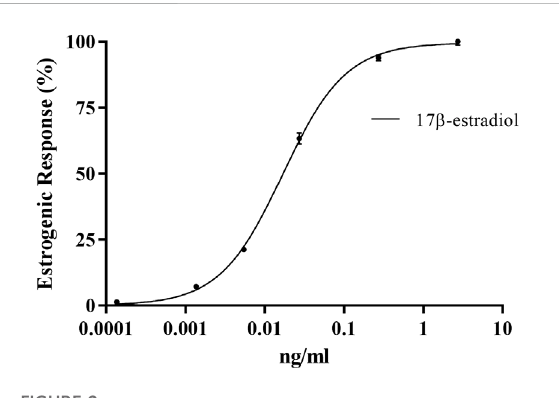
FIGURE 2 Dose-response curve of the estrogenic response of E2 with the MMV-Luc (estrogen responsive) RGA cell line. Values are means ± SEM for the three separate experiments ( n =